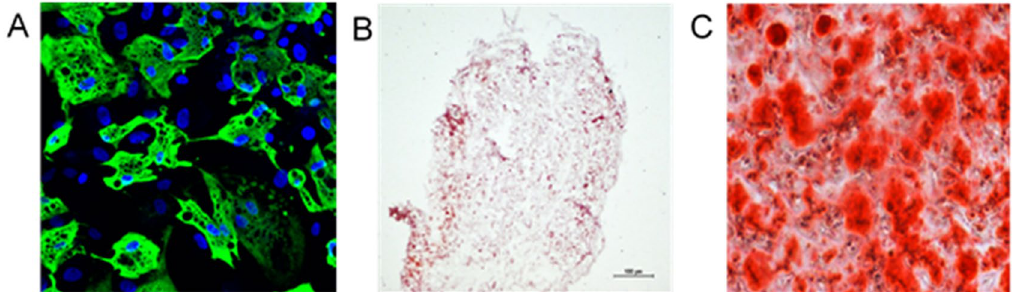
Figure 2. Differentiation of isolated cells. ( A ) MSC differentiated into adipocytes. Lipid vesicles stained with FABP4 antibody (green), lens magn. 20 ×, ( B ) MSC cells differentiated to chondroblasts stained with Safranin O, lens magn × 5, ( C ) osteoblast-differentiated MSC. Red colour indicates the presence of Ca 2+ calcium ions (bound by the dye—alizarin red), area 20 × objective,